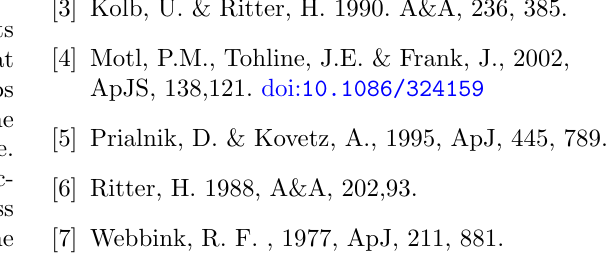
Figure 6: The flashes of nuclear energy as a function of